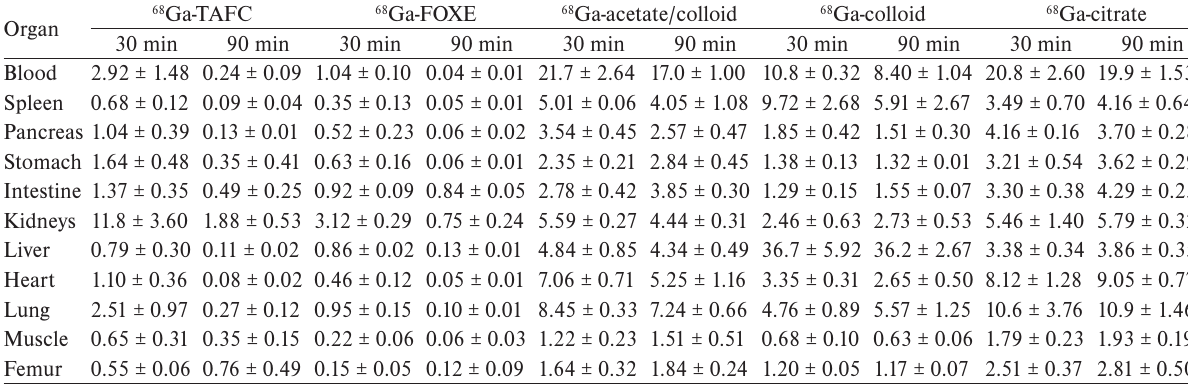
Fig. 1. Proposed chemical structures of 68 Ga-TAFC (A) and 68 Ga-FOXE (B) and HPLC-radiochromatograms of 68 Ga-TAFC, 68 Ga-FOXE and free 68 Ga Table 1. Biodistribution of 68 Ga-TAFC, 68 Ga-FOXE, 68 Ga-acetate/colloid, 68 Ga-colloid and 68 Ga-citrate in normal DBA/2 mice 30 min and 90 min p.i.